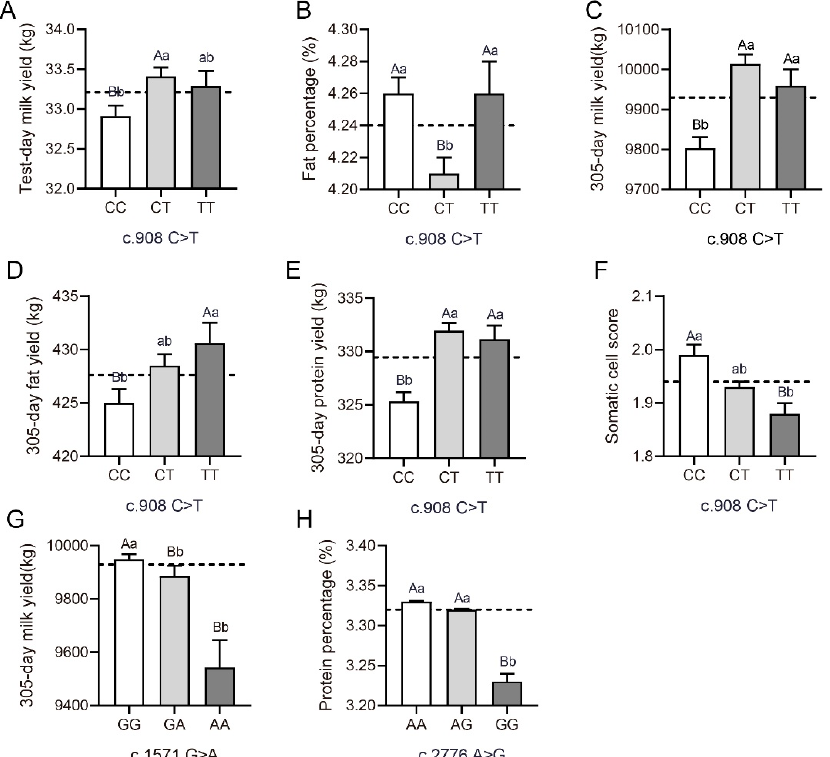
Figure 2. The e ff ects of investigated fatty acid desaturase 2 SNPs on milk production traits. ( A–F ) The SNP c.908 C > T was significantly associated with test-day milk yield, fat percentage and 305-day milk, fat and protein yield, and somatic cell score ( n = 6553 for CC; n = 8687 for CT; and n = 3024 for TT). ( G ) The GG genotype at the c.1571 G > A locus was linked to the highest 305-day milk yield ( n = 14578 for GG; n = 3313 for GA; and n = 373 for AA). ( H ) Substituting allele G for A at the c.2776 A > G locus resulted in a decrease of protein percentage ( n = 12110 for AA; n = 5619 for AG; and n = 518 for GG). Di ff erent lowercase letters indicate significant di ff erences between genotypes ( p < 0.05); Di ff erent uppercase letters indicate significant di ff erences between genotypes ( p < 0.01). Data shown are means ± SE. The dotted line represents the overall